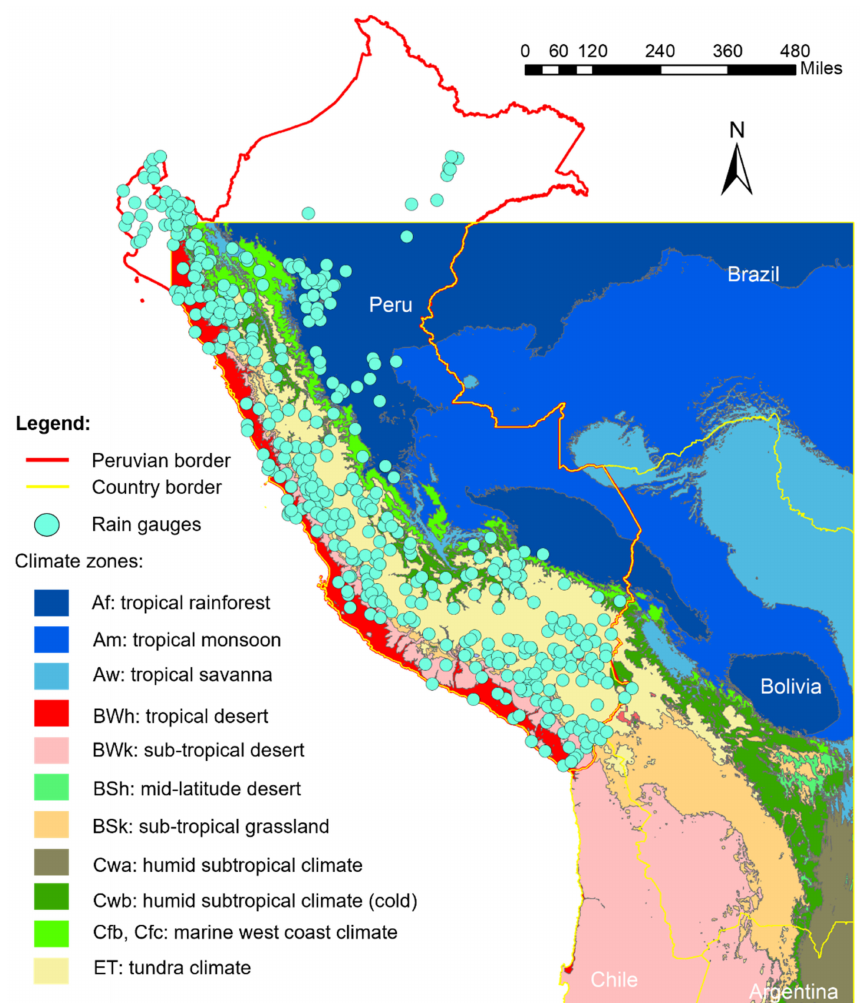
Figure 1. The study area and the Köppen–Geiger–Pohl climate zones in the study area.